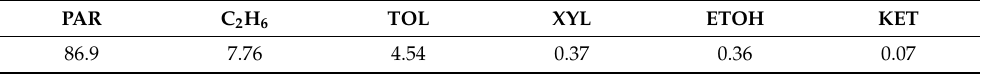
Table 4. Mass percentages of NMOC fugitive emissions for a hypothetical landfill.